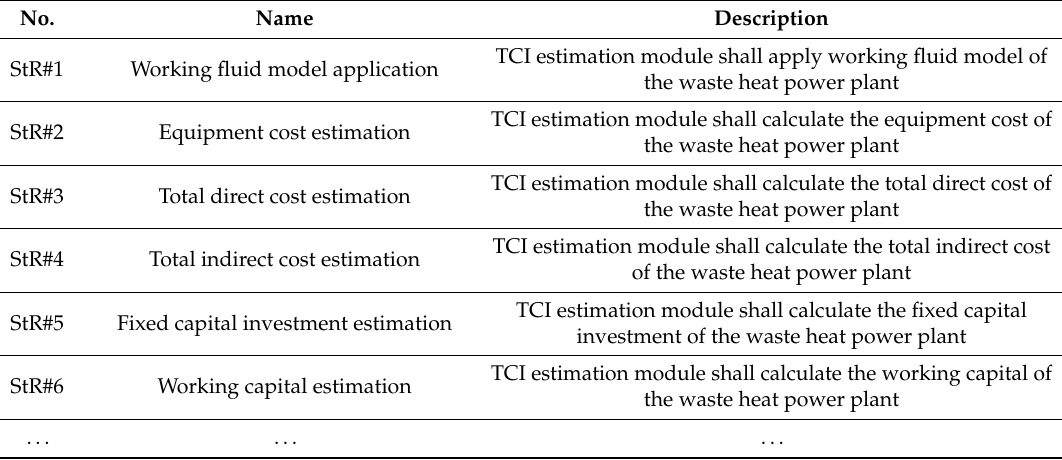
Table 4. Stakeholder requirements of the TCI estimation